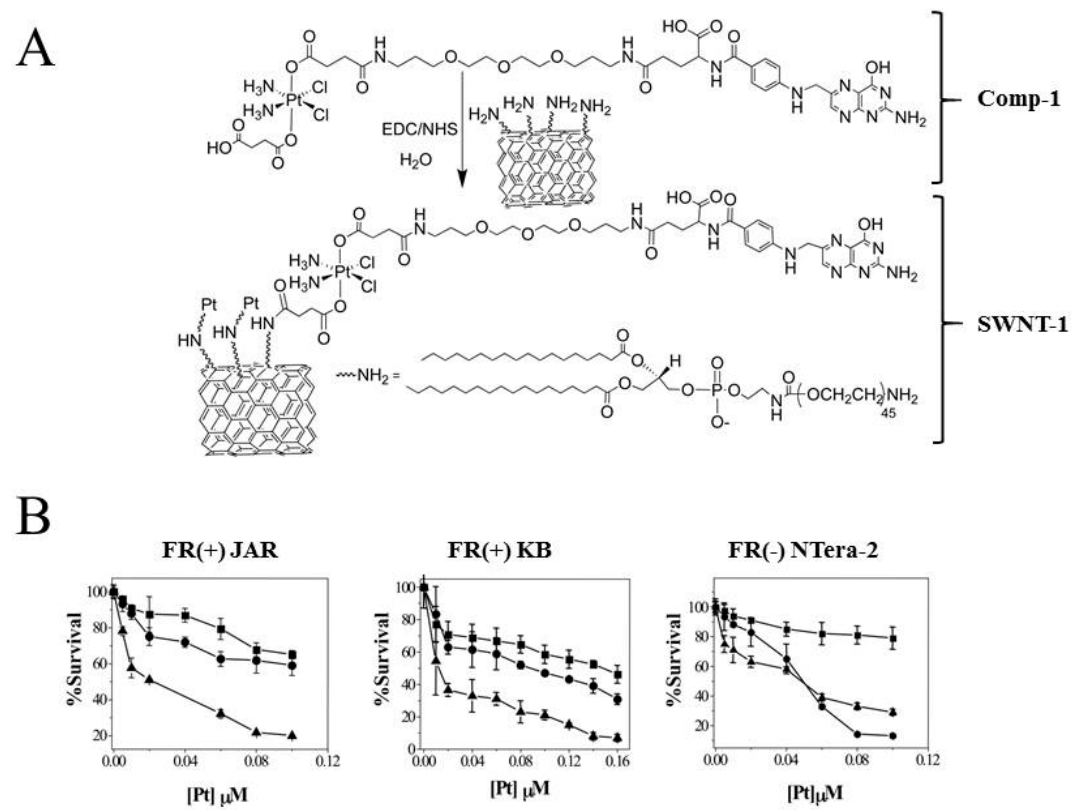
Figure 5. Cytotoxicity of Pt- compounds attached to nanotubes. ( A ) c , c , t -[Pt(NH 3 ) 2 Cl 2 (O 2 CCH 2 CH 2 CO 2 H) (O 2 CCH 2 CH 2 CONH-PEG-FA)] (Comp-1) is attached to the surface of the carbon nanotube (SWNT-PL-PEG-NH 2 ) forming SWNT-1; and ( B ) Survival of human nasopharyngeal epidermoid carcinoma (KB), choriocarcinoma (JAR), and human testicular cancer (NTera-2) cells treated with Comp-1 (square), SWNT-1 (triangle), or cisplatin (circle) at various concentrations for 72 tested by a MTT assay. Reproduced with permission from [71].